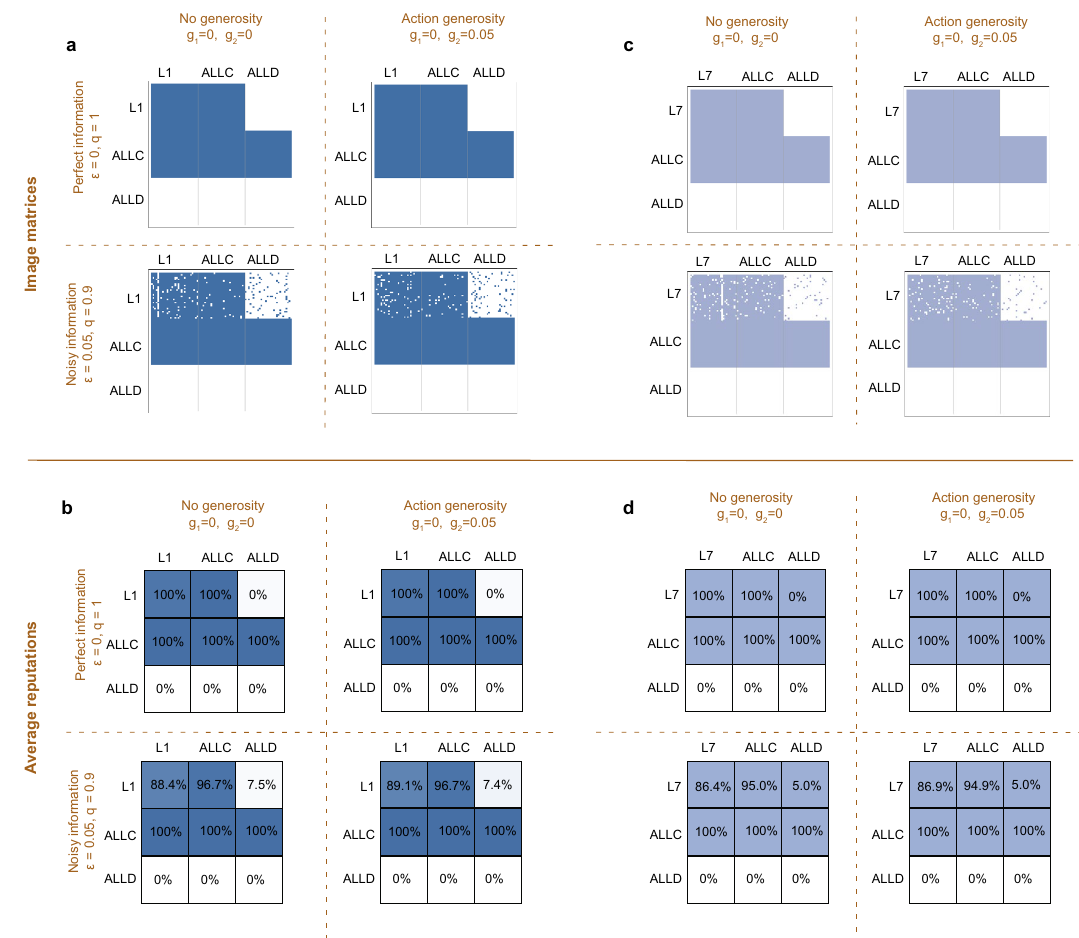
Figure 3. The effect of action generosity on the reputation dynamics. We consider the same basic setup as in Fig. 2, except that leading eight players now use action generosity instead of assessment generosity. ( a,b ) When the population consists of L 1 , ALLC , and ALLD , action generosity results in more appropriate judgments. In the presence of errors, generosity makes L 1 players more likely to perceive each other as good (89.1% instead of 88.4%). Similarly, it makes them slightly less likely to perceive defectors as good (7.4% instead of 7.5%). Importantly, however, L 1 players with action generosity occasionally cooperate with ALLD opponents even if they regard them as bad. ( c , d ) We observe the same patterns for other leading eight norms. Here we again depict the case of L 7 . Parameters are the same as in Fig.